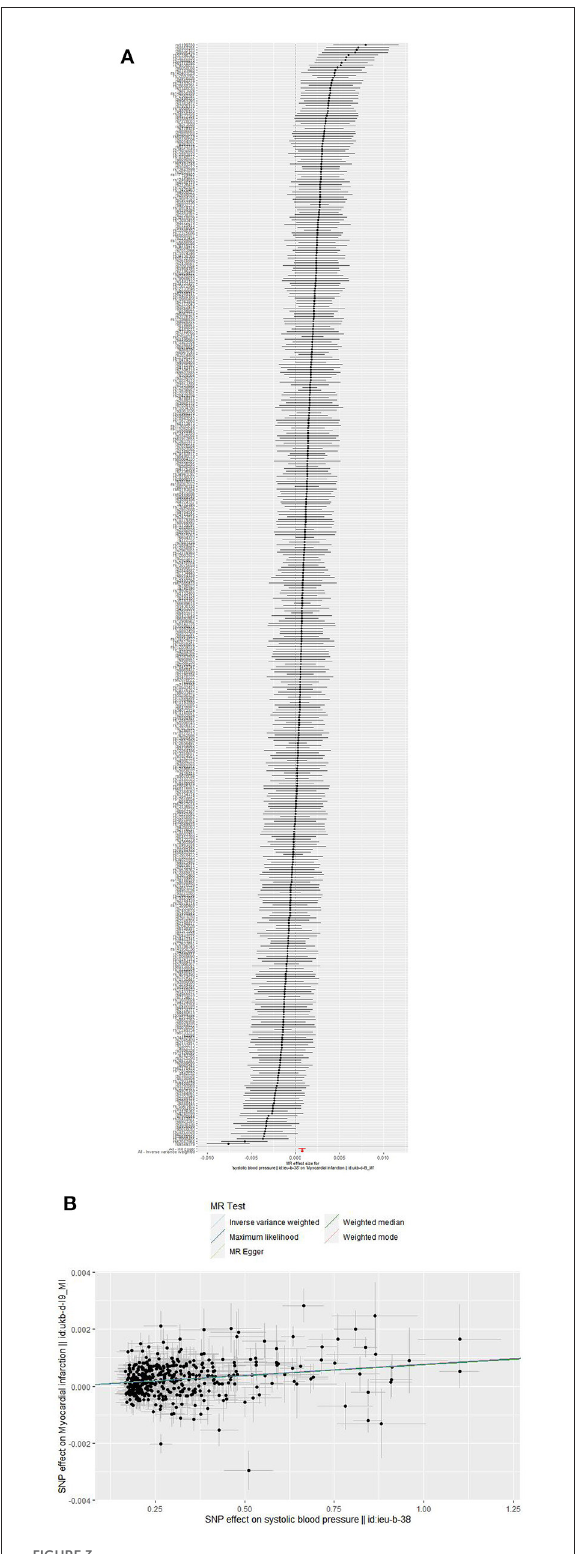
FIGURE3 (A,B) Forest plots (A) and scatter plots (B) of causal relationships between SBP-associated SNPs and risk of MI. The slopes of each line in the scatter plots represent the causal association for each